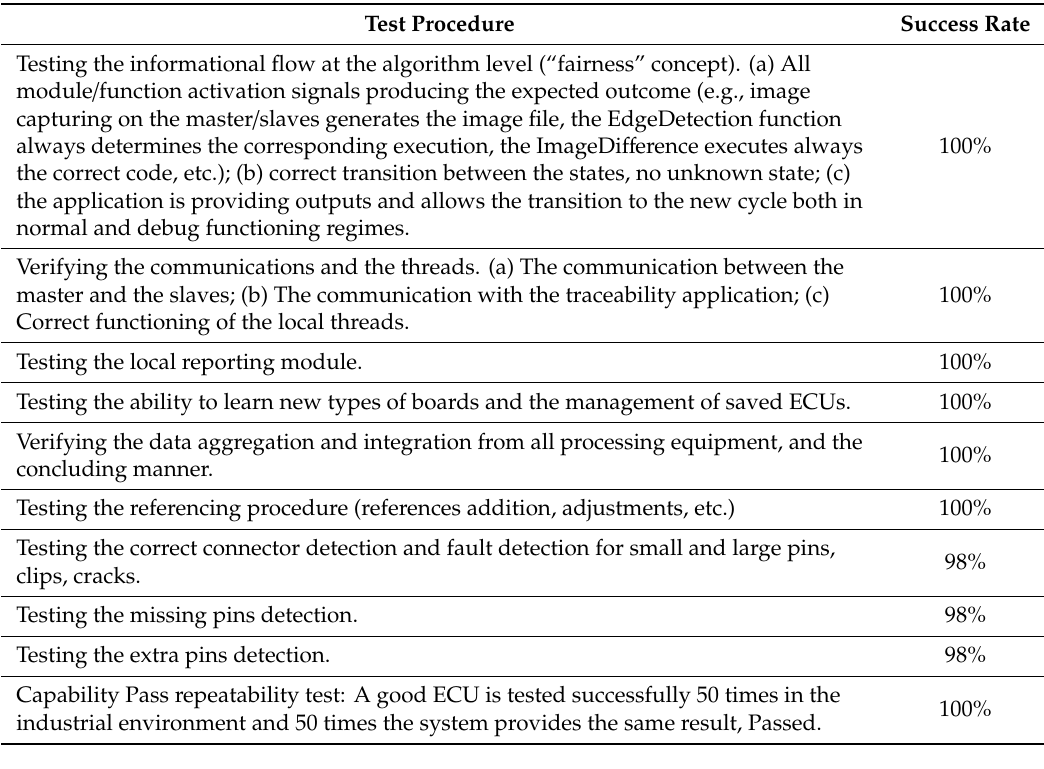
Table 1. Other results of the testing